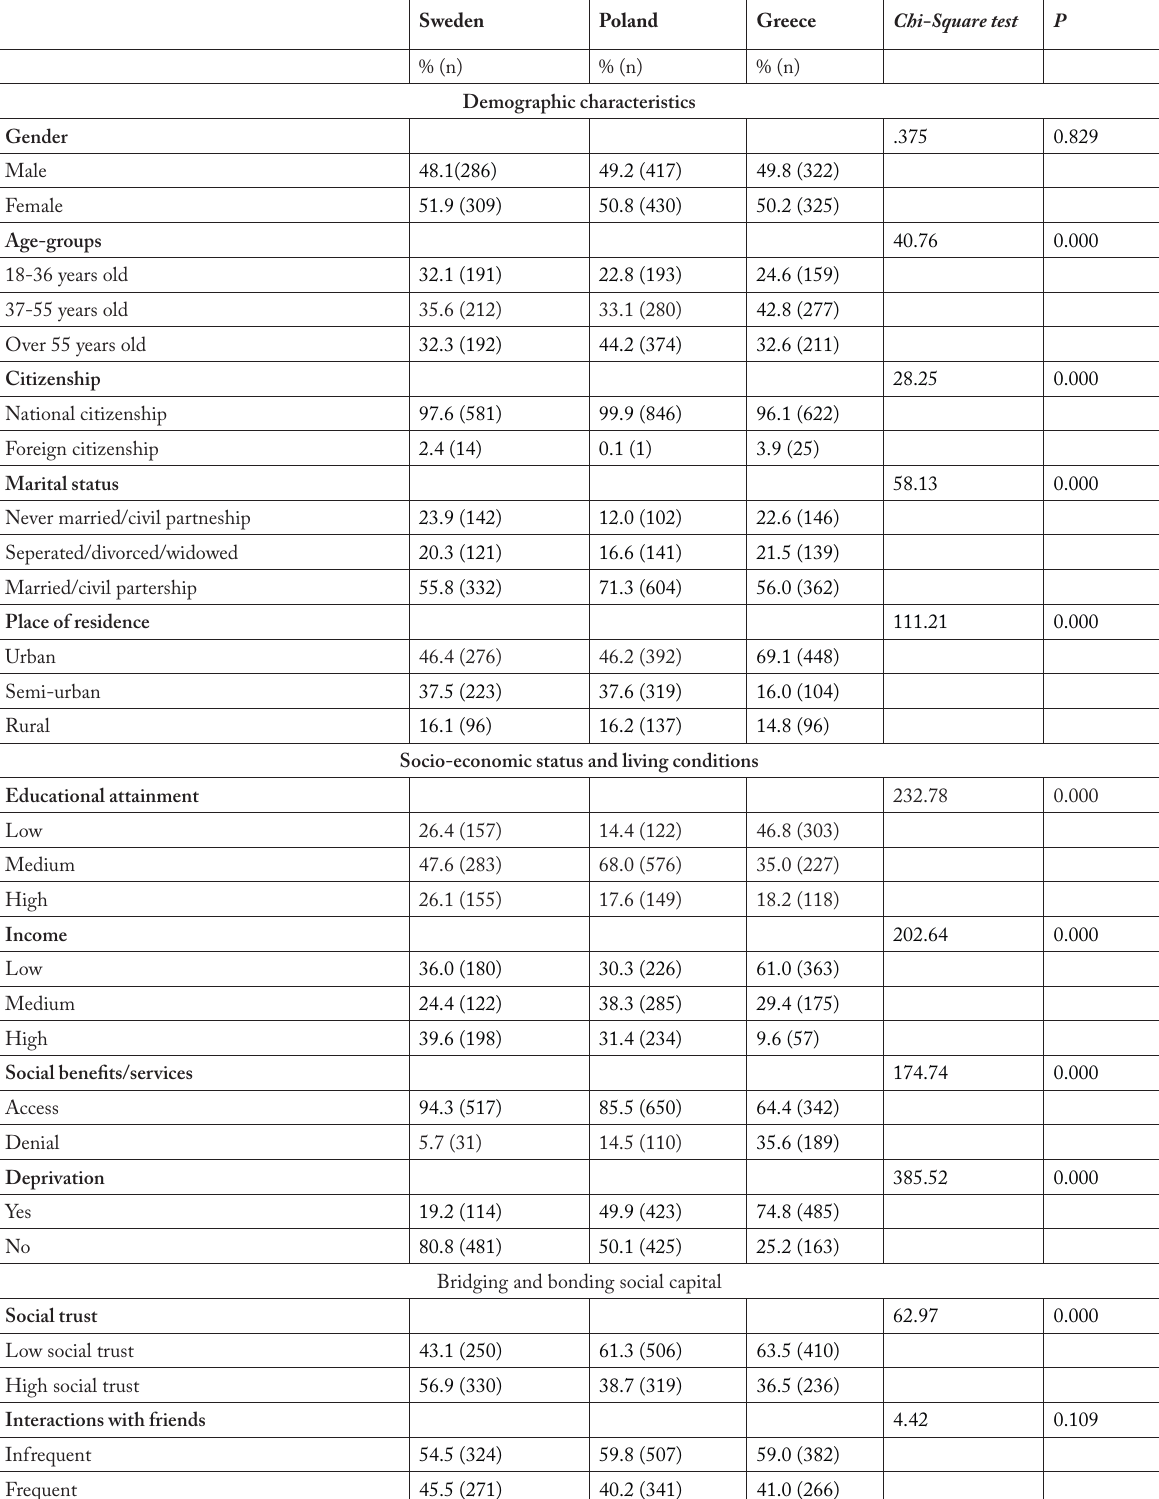
Table 1. Chi-Square analysis of individuals reporting poor health in Sweden (n = 595), Poland (n = 847) and Greece ( n =